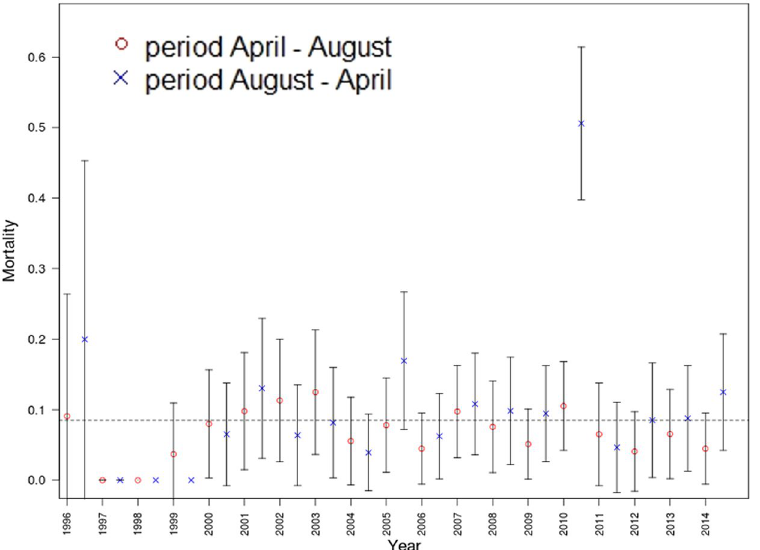
Figure 4. Mortality in ‘summer’ and ‘winter’ periods ( ± 2 s.e.).